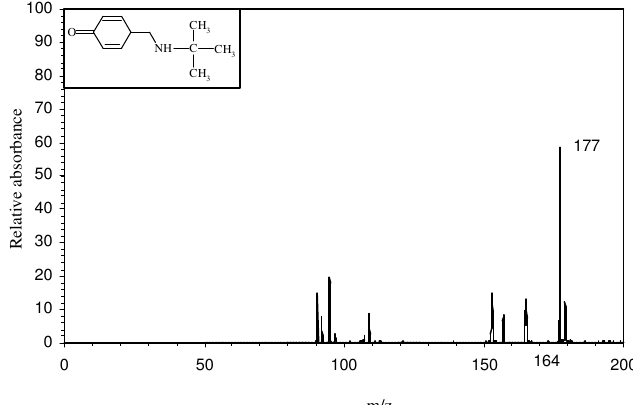
Figure 1. LC-ESI-MS spectra of oxidation of t -butylbenzylamine by diperiodatoargentate(III) in aqueous